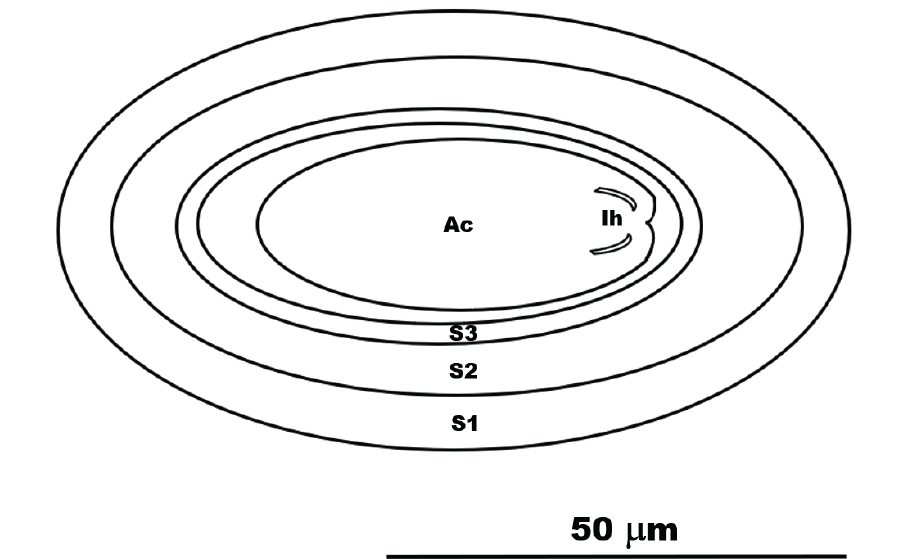
Figure 7 - representative drawing showing the morphology of Acanthocephala egg in coprolite preliminary assigned to Crocodyliformes dated around 80-70 million years old. Abbreviations: S1 = first shell; S2 = second shell; S3 = third shell; Ac = acanthor; Ih = inconspicuous hooks in the anterior portion of